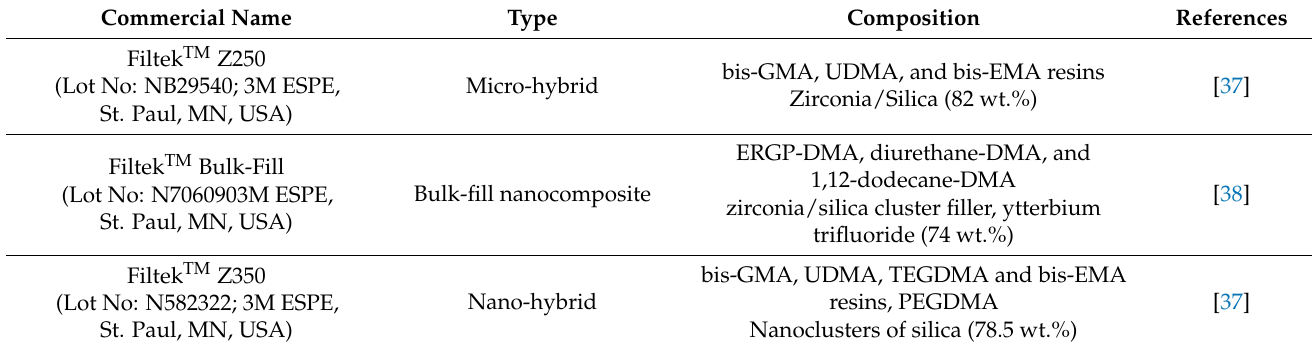
Table 1. Composition of commercially used dental restorative